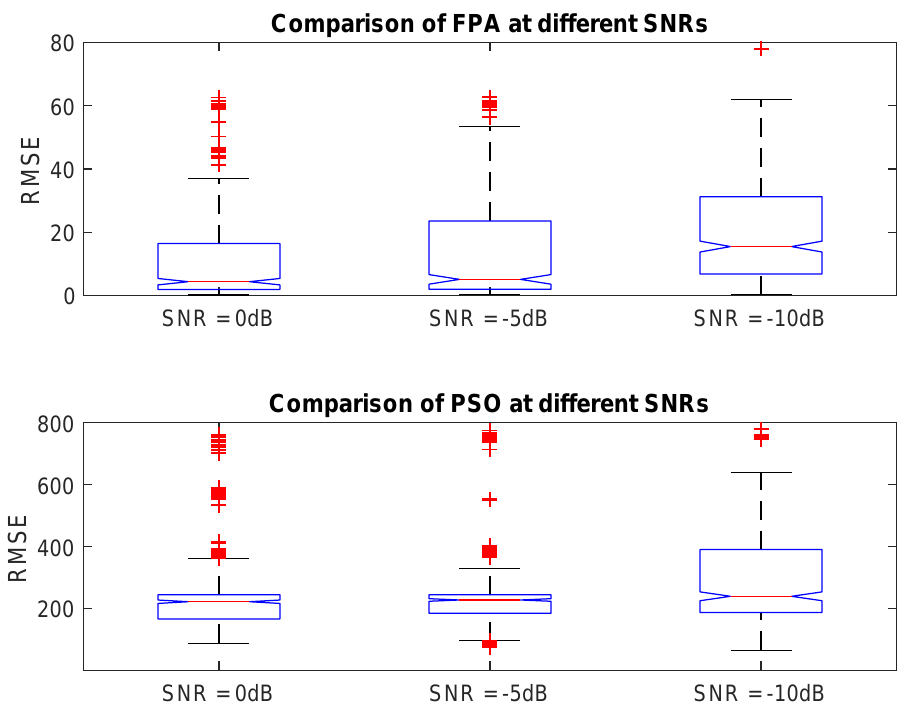
Figure 10. Variation analysis of RMSE for seven